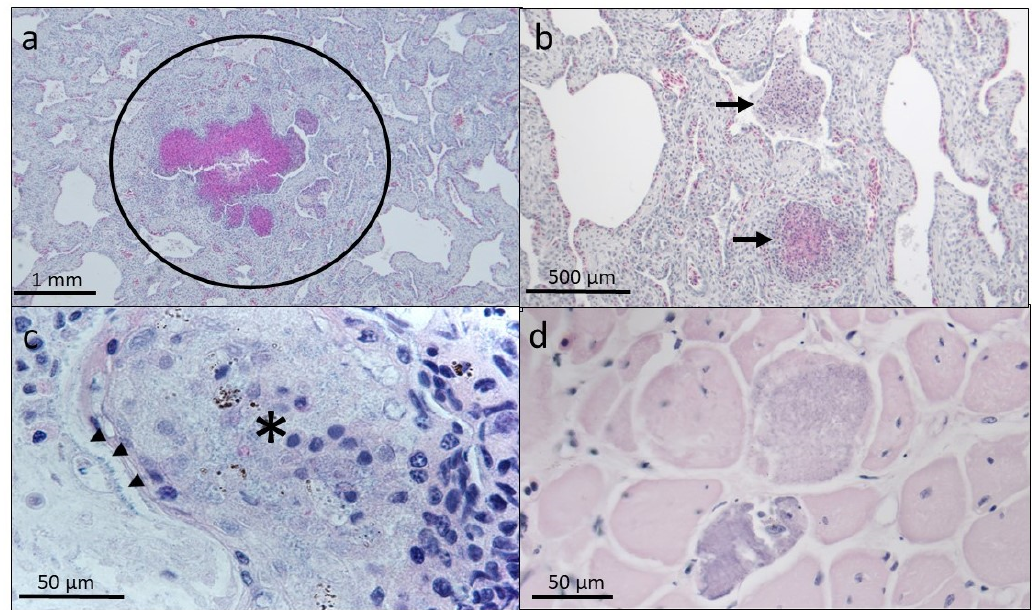
Figure 4. Histopathologic findings in leatherback sea turtle ( Dermochelys coriacea ) post-hatching mortalities. ( a ) Large focus of heterophilic debris and necrosis within the airway of a bronchi (circled). ( b ) Multiple areas of cellular and heterophilic debris within falveolar spaces (arrows). ( c ) Cellular and acellular debris within faveolar spaces is associated bacteria lining the bronchi epithelium (arrowheads). ( d ) Disruption of the sarcolemma of two skeletal muscle bundles by mineral deposits.